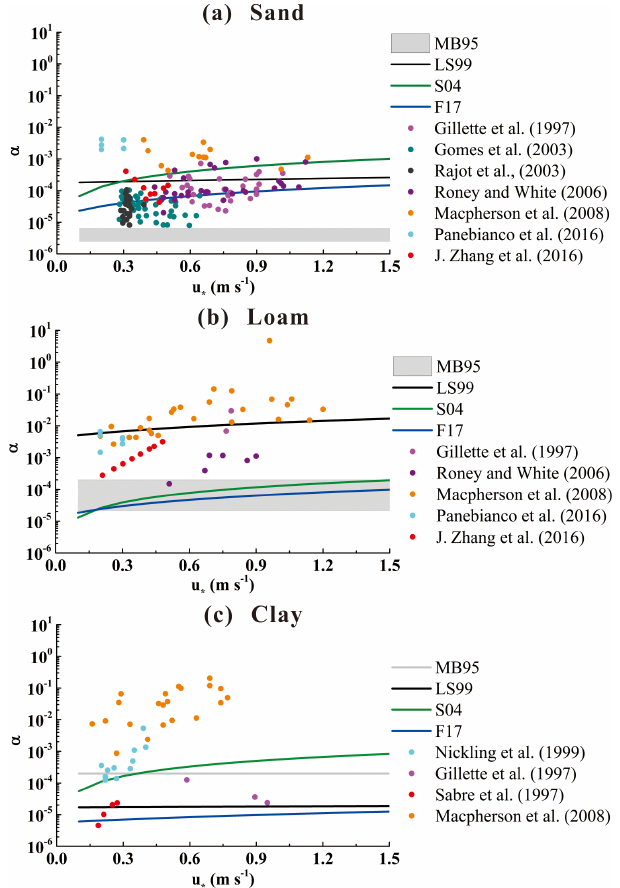
Figure 8. Vertical-to-horizontal dust flux ratio ( α ) for sand (a) , loam (b) , and clay (c) as a function of friction velocity ( u ∗ ) following Marticorena and Bergametti (1995) (MB95), Lu and Shao (1999) (LS99), Shao (2004) (S04), Foroutan et al. (2017) (F17), and observations from the